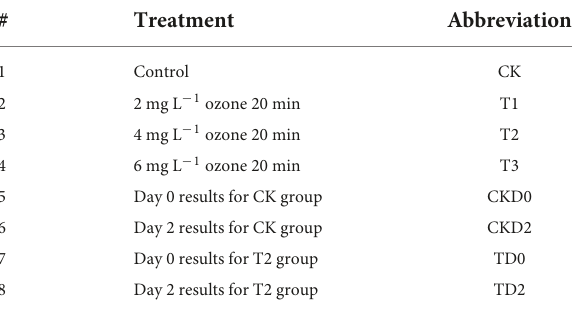
TABLE 1 Treatmentsprepared for the